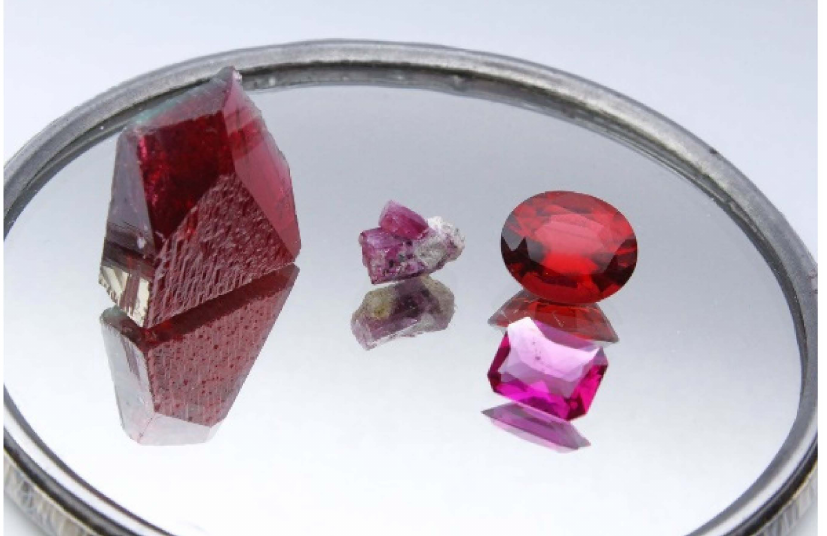
Figure 2. The gem-quality red beryls analyzed in the present study. The rough sample (BS1R, 18.38 ct) on the left is a hydrothermally grown synthetic beryl, as well as the two faceted samples on the right (above BS2G, 4.10 and below BS3G, 1.41 ct). The sample in the middle is a rough of a natural red beryl (1.91 ct in total), consisting of two crystals, the smallest of which was investigated in the present study. BS1R dimensions: 18.88 mm × 18.38 mm × 6.70